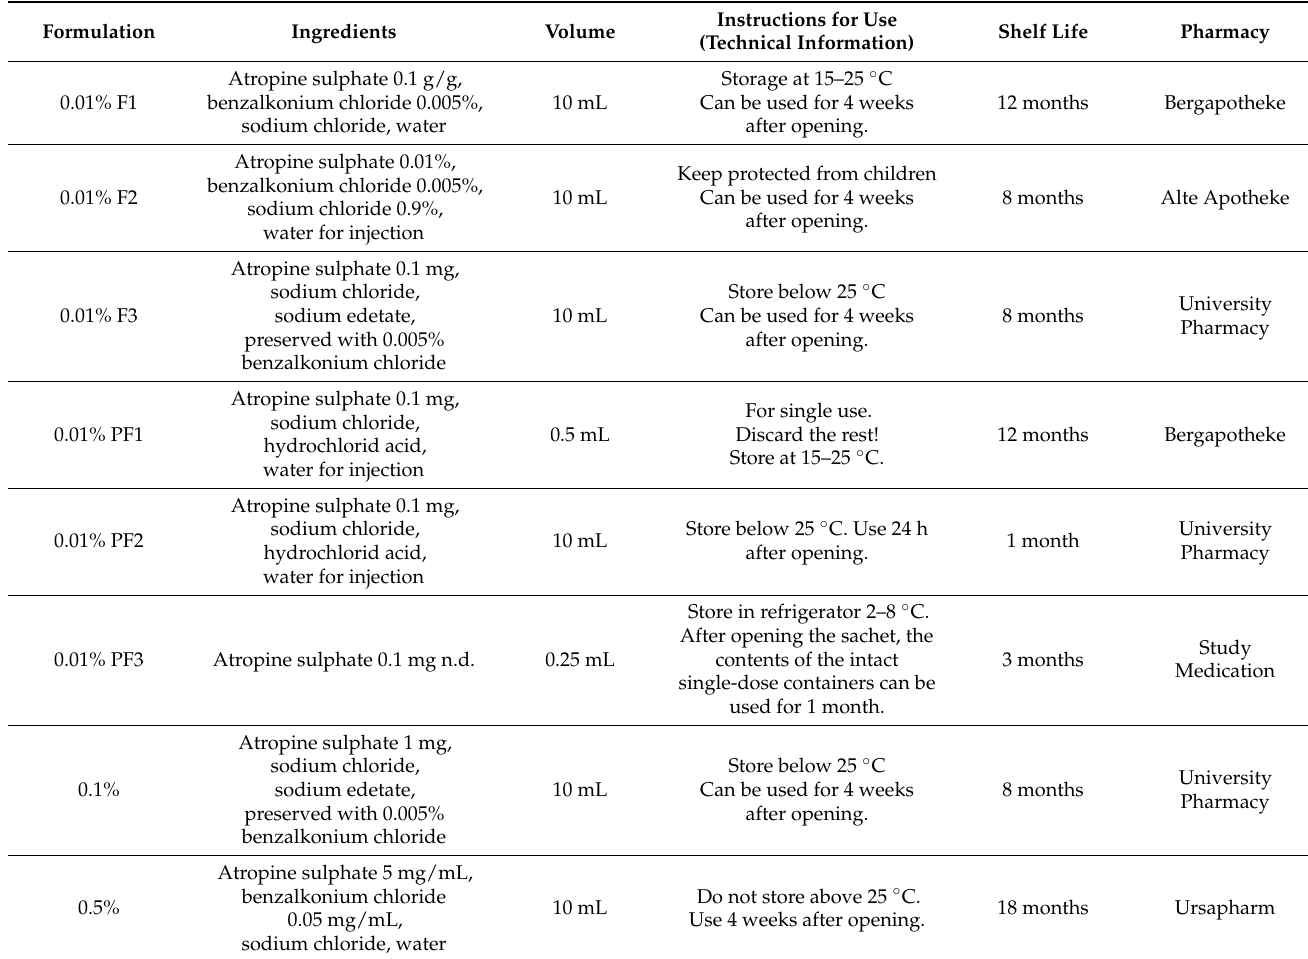
Table 1. Overview of tested